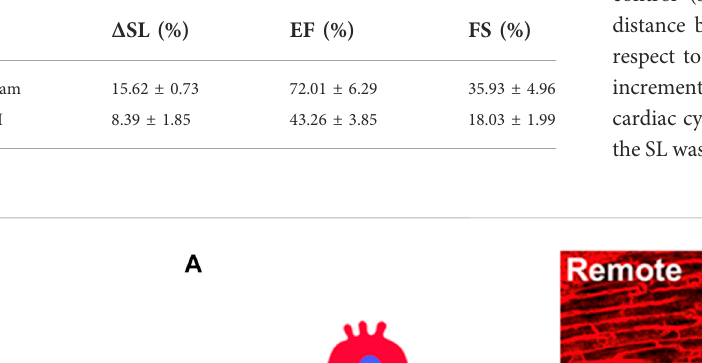
TABLE 1 Correlation between the sarcomere shortening percentage (% Δ SL) and heart function (EF and FS).